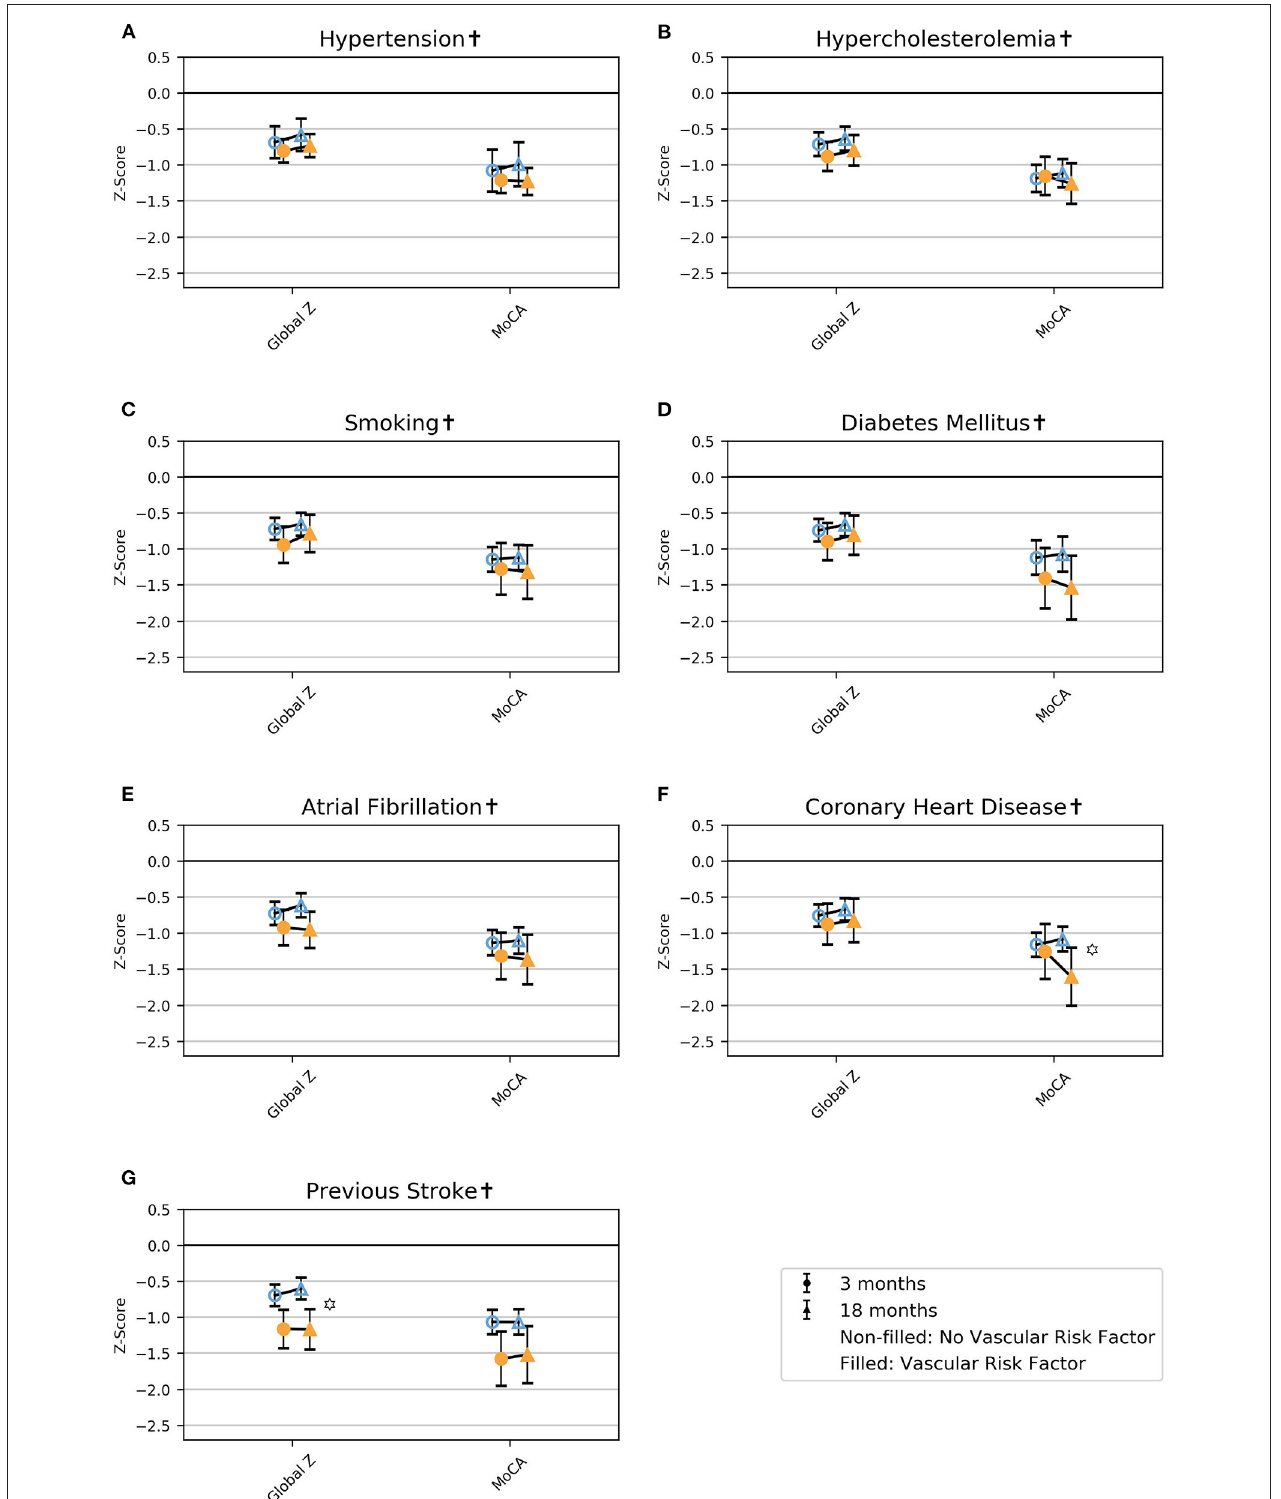
FIGURE 2 | Mean z-score with 95% CI for the global cognitive measures for the different vascular risk factors at 3 and 18 months post-stroke in model 1. MoCA, Montreal Cognitive Assessment. (A) hypertension, (B) hypercholesterolemia, (C) smoking, (D) diabetes mellitus, (E) atrial fibrillation, (F) coronary heart disease, (G) previous stroke. † Adjusted for age, education, and sex. LRvasc χ 2 (2) p < 0.01.